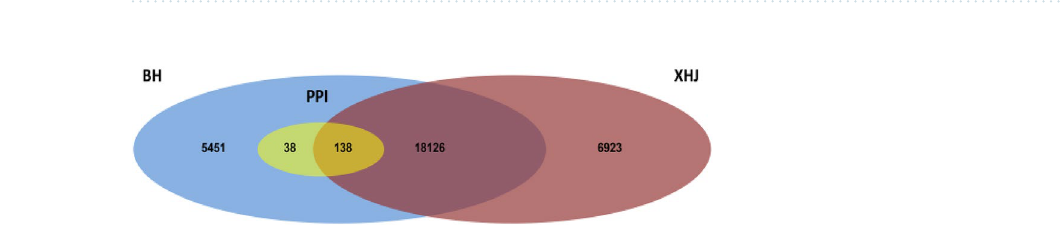
Figure 3. Scatterplot of KEGG pathways enrichment analysis for upregulated DEGs at ( a ) 6, ( b ) 12, ( c ) 24, and ( d ) 60 hpi in BH. The rich factor is the ratio of the number of DEGs annotated in a given pathway term to the number of all genes annotated in the pathway term. A higher rich factor indicates greater intensity. The Q value is the corrected P value and ranges from 0 to 1, with a lower Q value indicating greater intensity. The sizes of the circles indicate the number of genes. The top 20 enriched pathway terms in the KEGG database are listed. The blue arrows indicates the plant-pathogen interaction pathway.